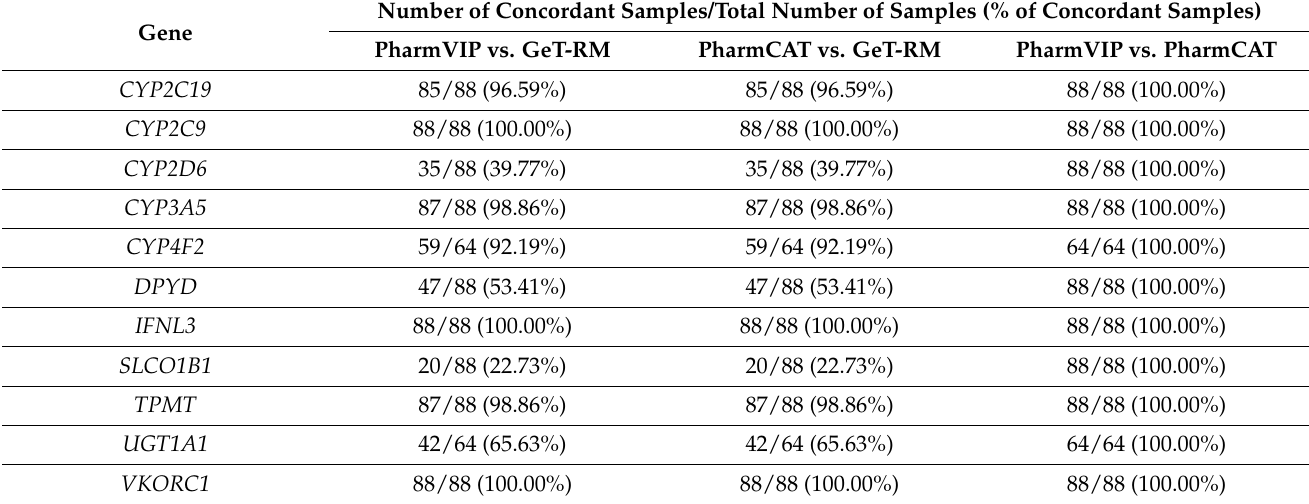
Table 1. Comparison of diplotype assignment results obtained from PharmVIP, PharmCAT, and GeT-RM. Number of Concordant Samples/Total Number of Samples (% of Concordant Samples) Gene PharmVIP vs. GeT-RM PharmCAT vs. GeT-RM PharmVIP vs. PharmCAT CYP2C19 85/88 (96.59%) 85/88 (96.59%) 88/88 (100.00%) CYP2C9 88/88 (100.00%) 88/88 (100.00%) 88/88 (100.00%) CYP2D6 35/88 (39.77%) 35/88 (39.77%) 88/88 (100.00%) CYP3A5 87/88 (98.86%) 87/88 (98.86%) 88/88 (100.00%) 59/64 (92.19%) 59/64 (92.19%) 88/88 (100.00%) 88/88 (100.00%) 88/88 (100.00%) 88/88 (100.00%) SLCO1B1 20/88 (22.73%) 20/88 (22.73%) 88/88 (100.00%) TPMT 87/88 (98.86%) 87/88 (98.86%) 88/88 (100.00%) UGT1A1 42/64 (65.63%) 42/64 (65.63%) 64/64 (100.00%) VKORC1 88/88 (100.00%) 88/88 (100.00%) 88/88